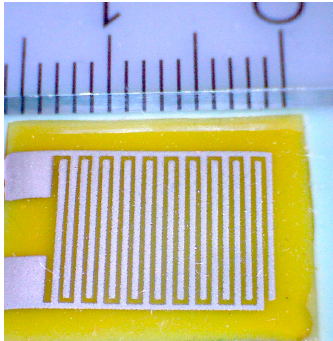
Figure 1. A photograph of a screen-printed interdigital capacitive structure on flexible RTM6 substrate (the small scale is in mm).